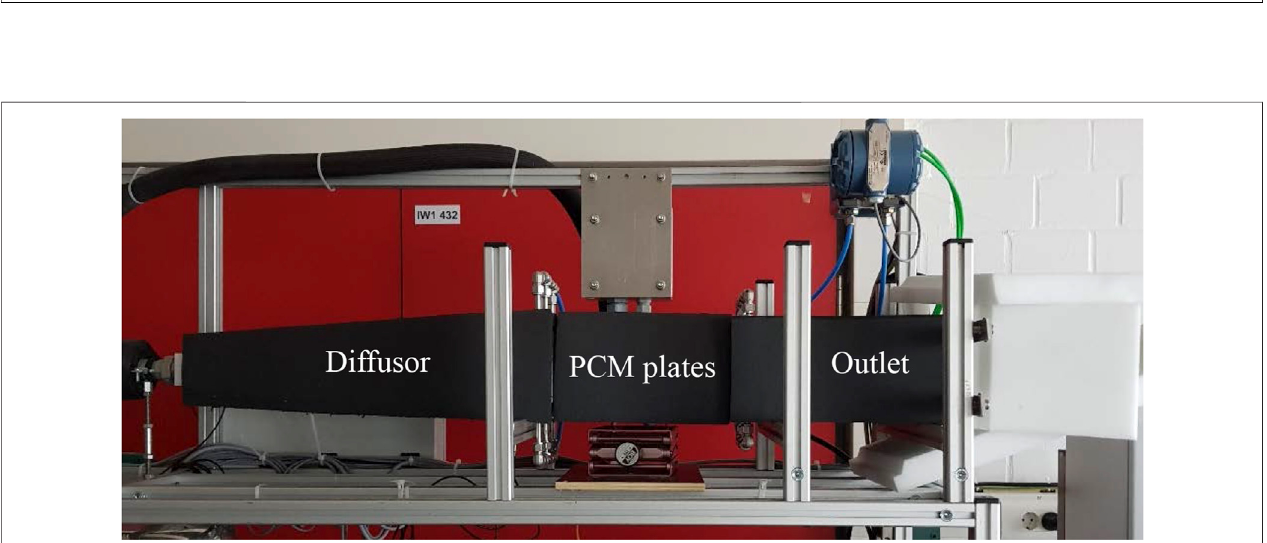
FIGURE 4 | The experimental setup.